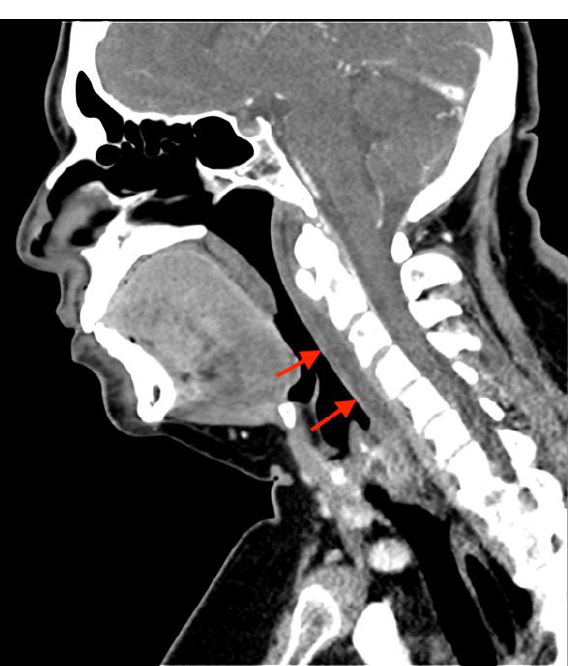
Image 2. Sagittal computed tomography image in soft tissue window showing diffuse retropharyngeal edema